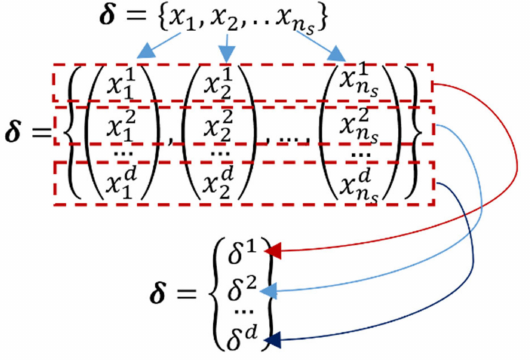
Figure 2. The relationship between the path node x i , path node component x j path component δ j